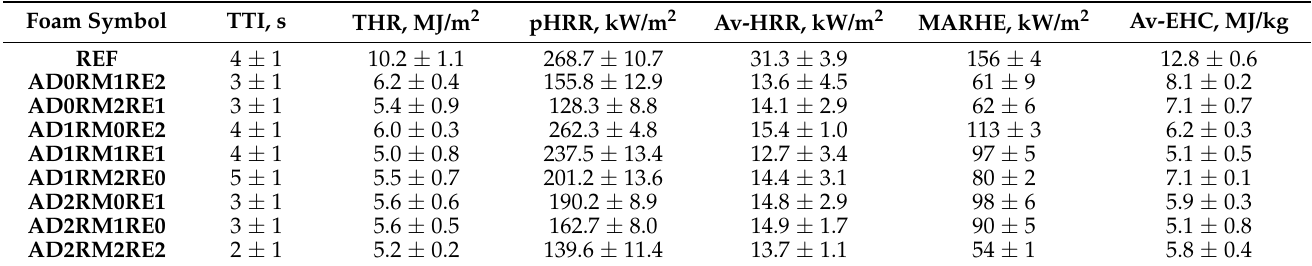
Table 7. Parameters of the combustion process after analysis with a cone